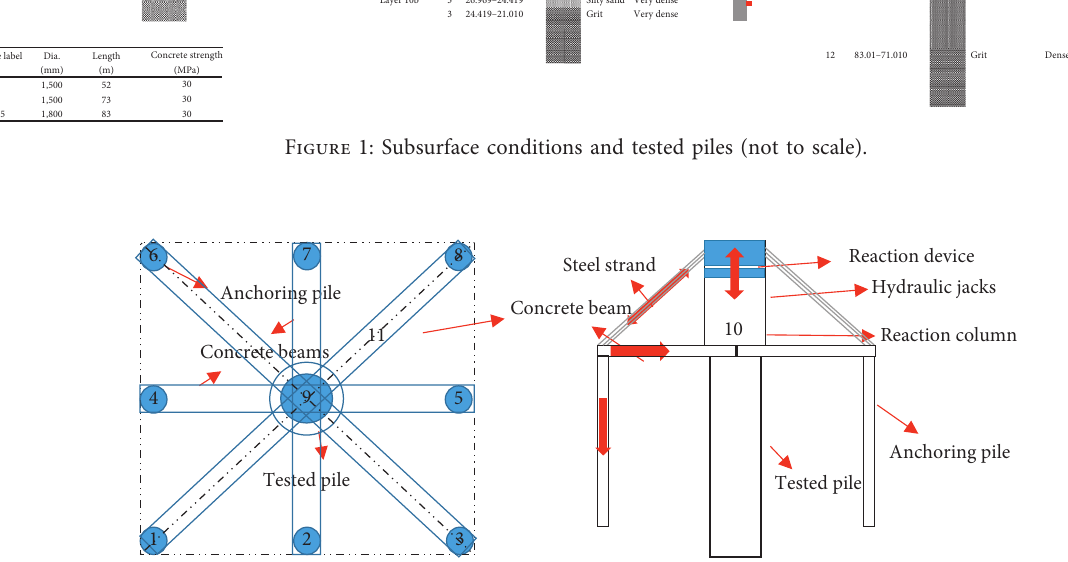
Figure 2: Reaction system design. (a) Plain view of the test setup (not to scale). (b) Mechanical mechanism.